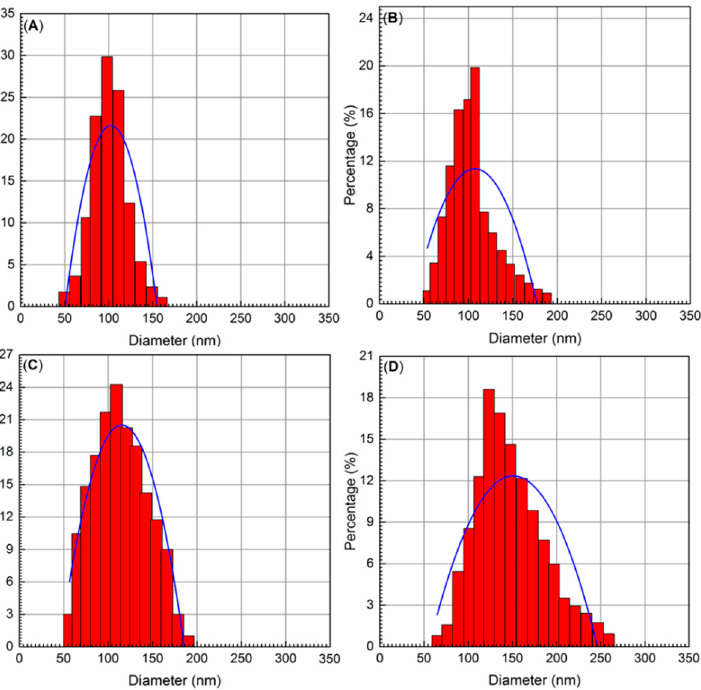
Figure 3. PSD histograms of NFs obtained using different PBA-CSNPs: ( A ) CSNPs, ( B ) PBA-CSNPs, ( C ) PBA-CSNPs-VOO, and ( D ) PBA-CSNPs-HT.